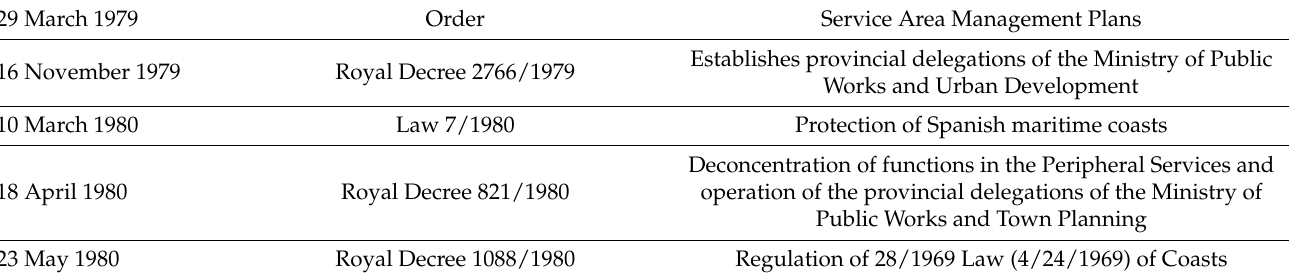
Table A1. Legislative